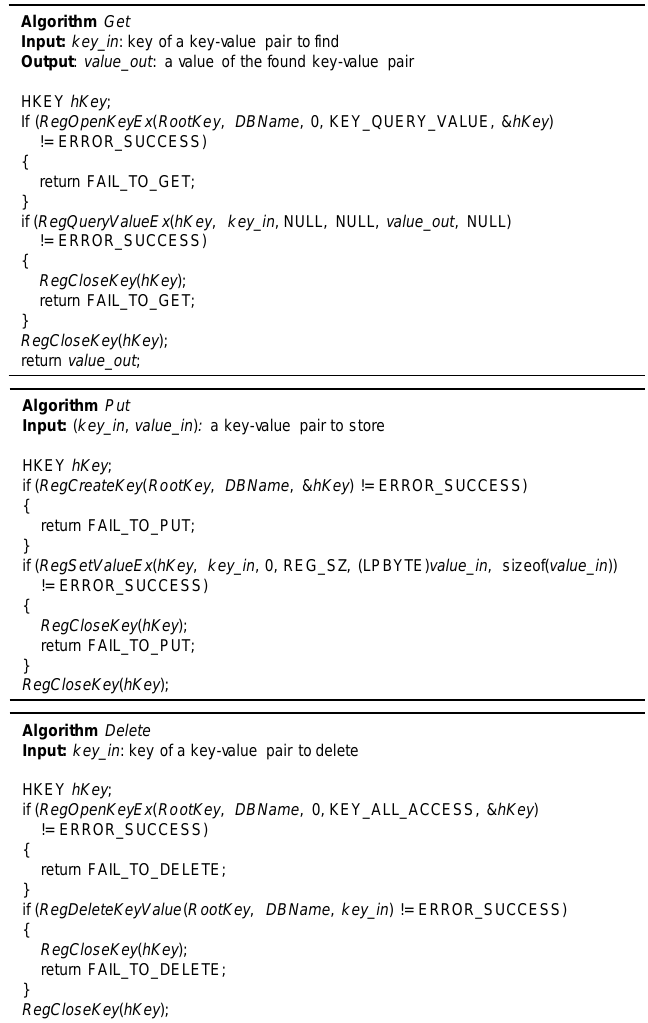
Figure 4. Processing algorithms for